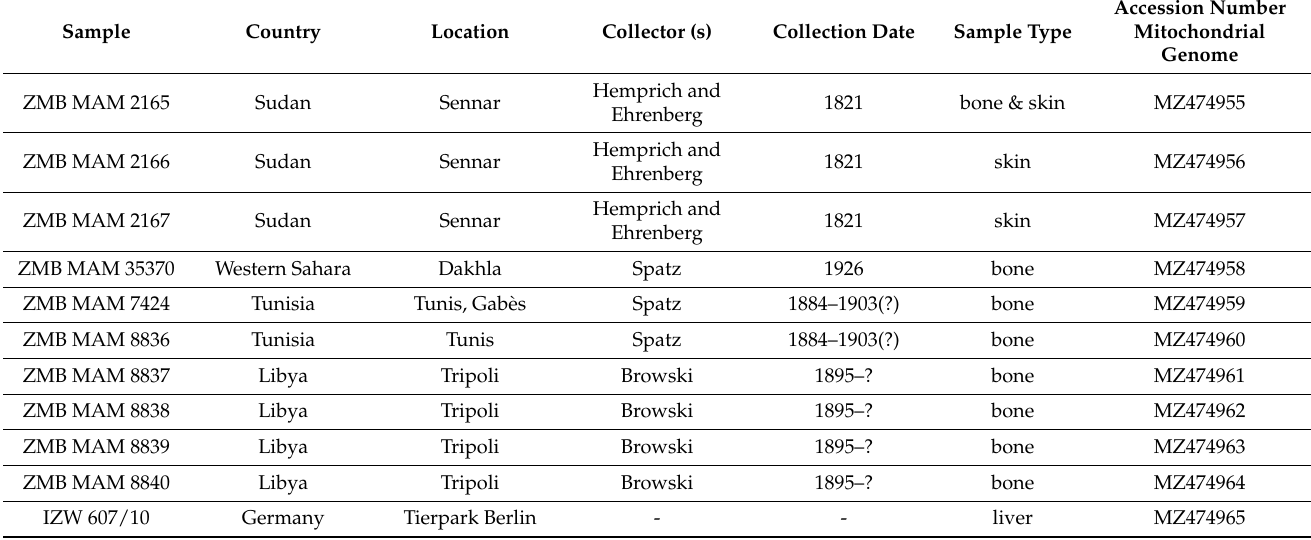
Table 1. Historical and contemporary samples of addax ( Addax nasomaculatus ) from the mammal collection of the Museum für Naturkunde, Berlin (ZMB) and the Institute of Zoo and Wildlife Research (IZW), Berlin, Germany. Accession numbers for the mitochondrial genomes generated in this study are